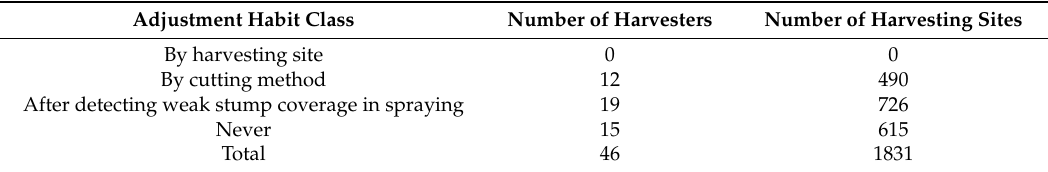
Figure 2. The distribution of the number of open holes in harvesters’ stump treatment guide bars by cutting method in the study. Table 1. The number of harvesters and harvesting sites in the different adjustment habit classes by harvester operator in the study.